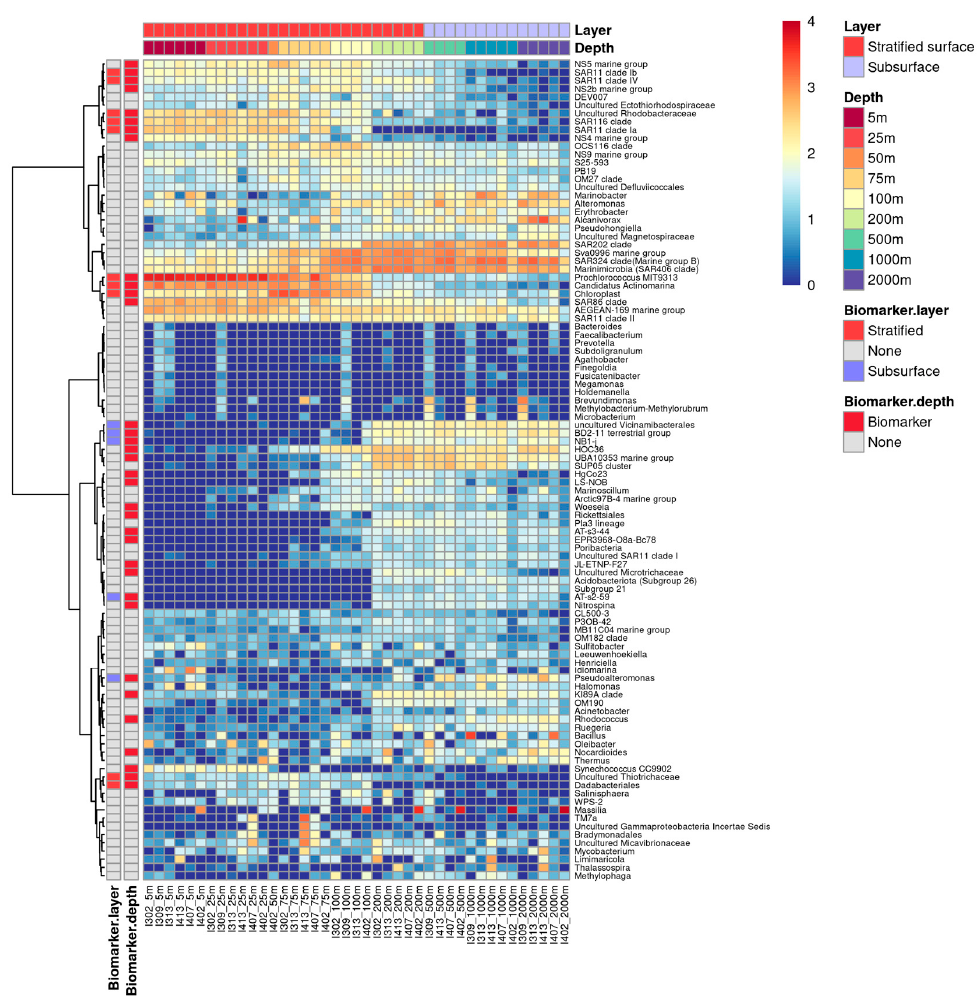
Figure 9. Heatmap of top 100 abundance genus. The relative abundance was log10 transformed and scaled by row. Genera (rows) are clustered by similarity using Ward’s hierarchical agglomerative method and labeled with results of ANCOM. Genera identified as biomarker of depths ( p < 0.05) were labeled red in the bar of “Biomarker-depth”. Genera identified as biomarker in stratified-surface layer were labeled red, whereas genera identified as biomarker in subsurface layer were labeled blue in the bar of “Biomarker ‐ layer” ( p < 0.05).